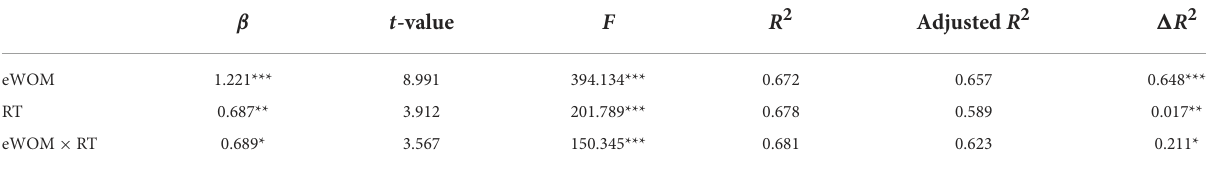
TABLE 6 The moderating effect of risk-taking in males.